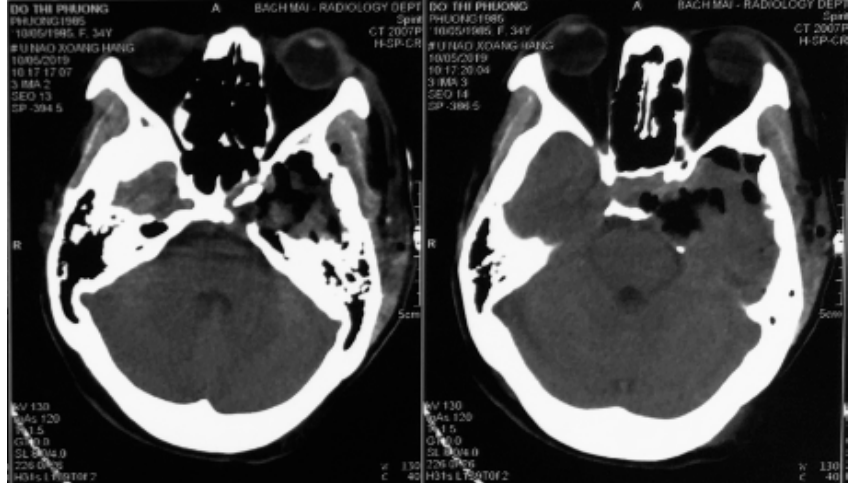
Figure 3. Two-day postoperative computed tomography scan images.